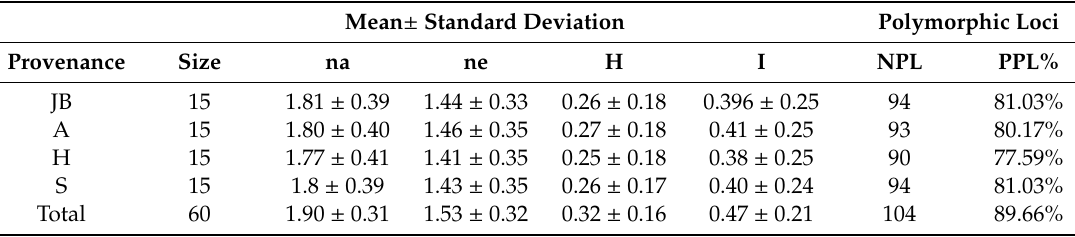
Table 3. Intra-population diversity measures of Argania spinosa based on ISSR data.